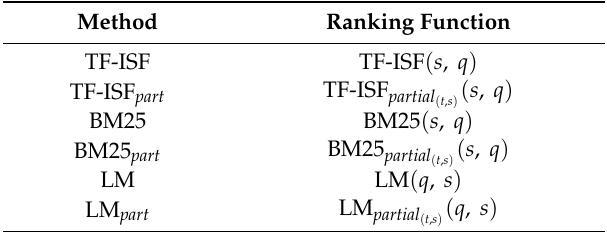
Table 1. Overview of all sentence retrieval methods tested in this paper.